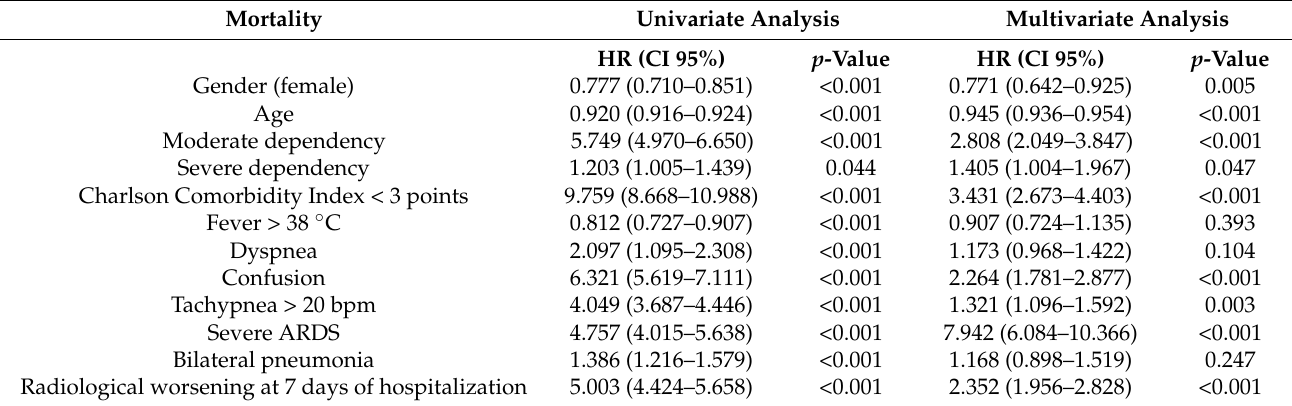
Table 5. Independent variables associated with in-hospital